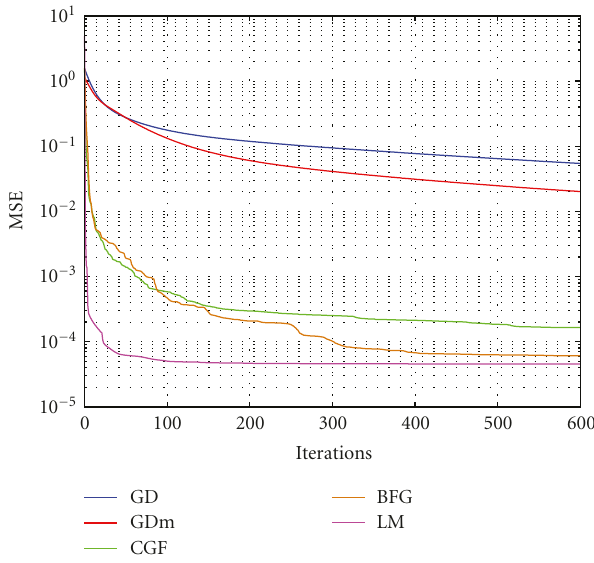
Figure 17: Mean square error versus iteration for di ff erent